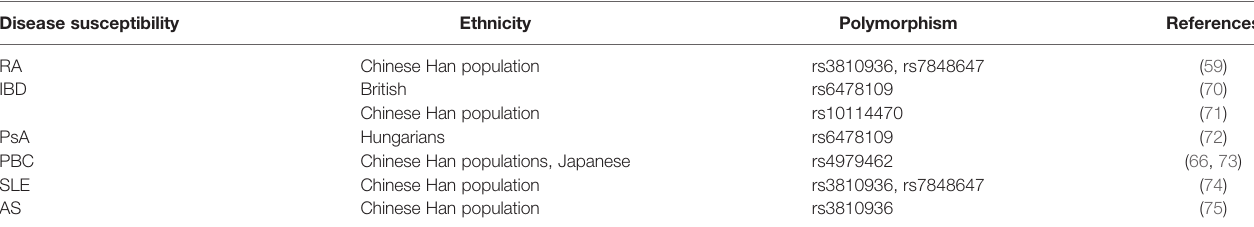
TABLE 2 | Relationship between tnfsf15 gene polymorphism and susceptibility to in fl ammatory autoimmune